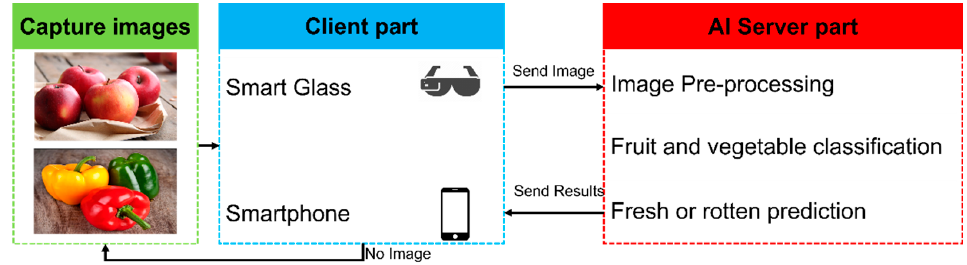
Figure 9. The overall diagram of the client-server architecture for mobile application.